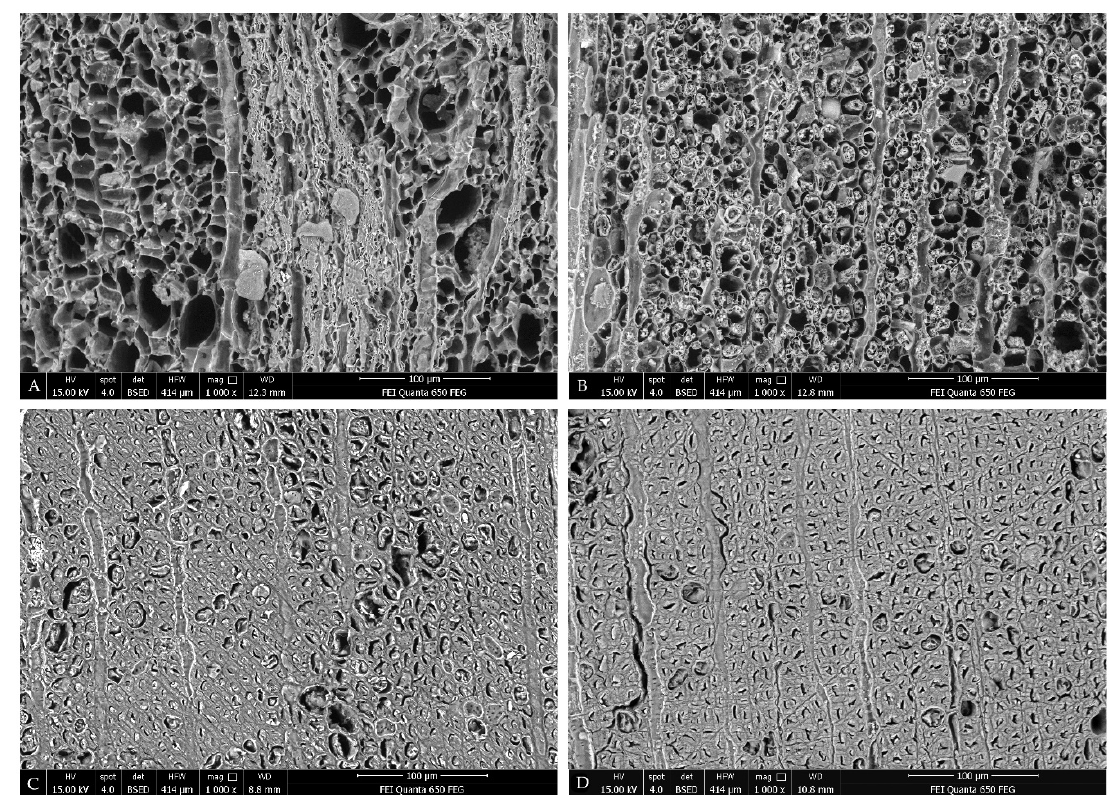
Figure 2. SEM images of air-dried archaeological elm samples: ( A ): untreated; ( B ): treated with MTMS.